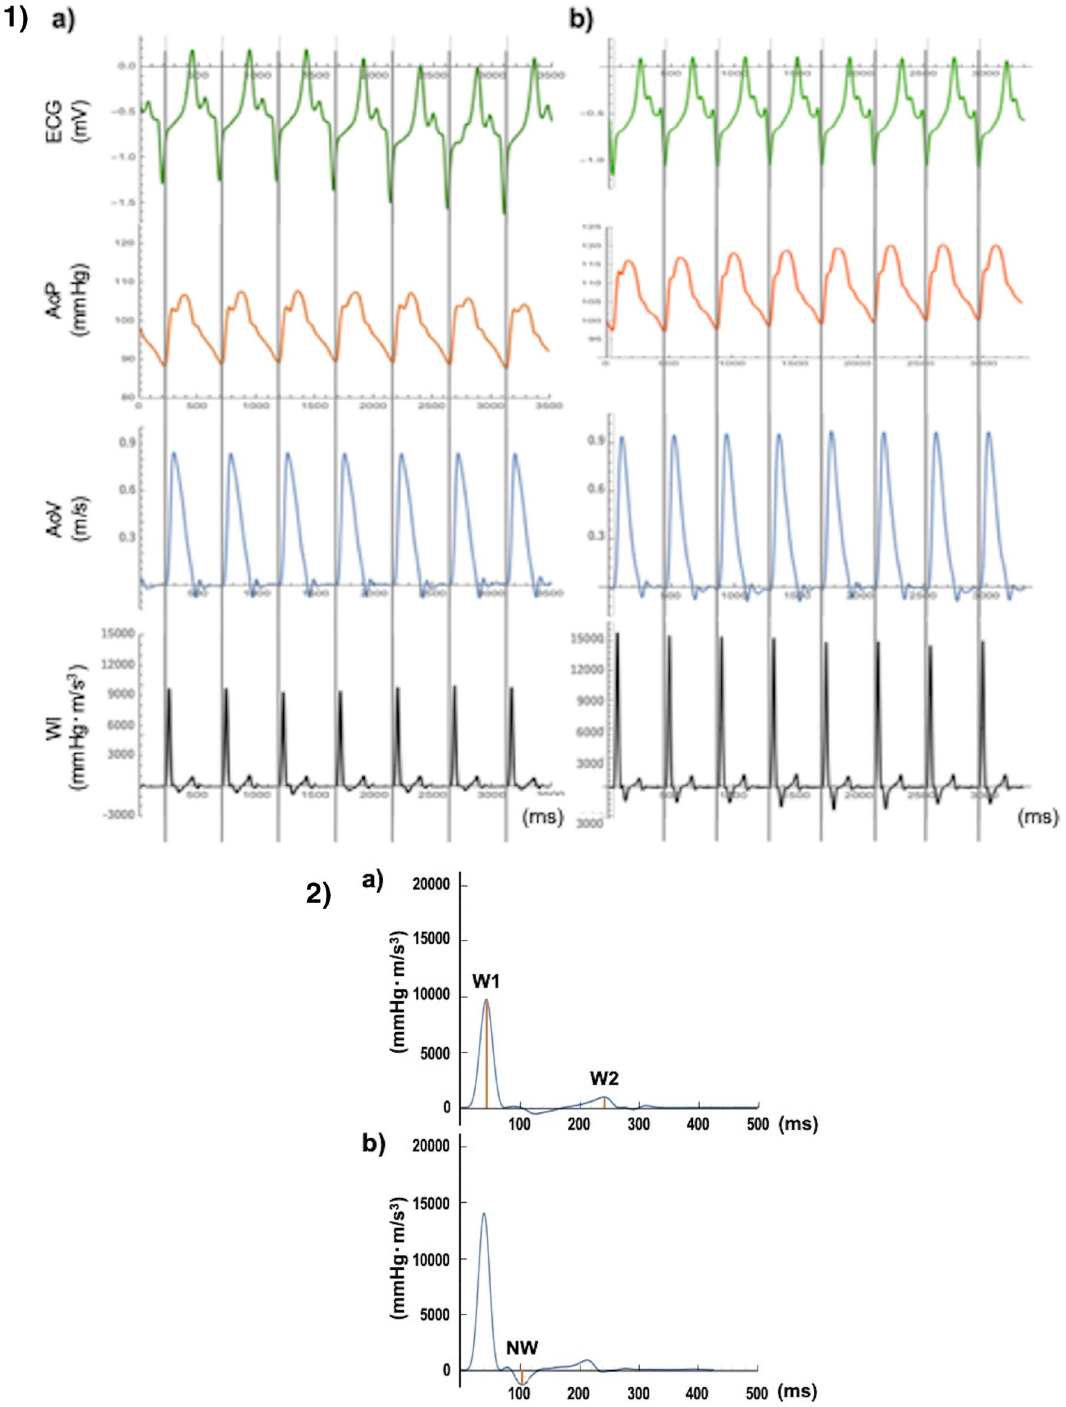
Figure 4. ( 1 ) Representative examples of waveforms measured at baseline (a) and after EVAR (b). ECG, ascending aortic pressure (AoP), aortic velocity (AoV) and calculated wave intensity (WI) obtained from eight successive beats in the ascending aorta. ( 2 ) Representative case of wave intensity at baseline (a) and after EVAR (b). There was an increase in W1 and a decrease in NW after EVAR. W1: first peak during early systole, W2: second peak during end of ejection, NW: backward wave in mid